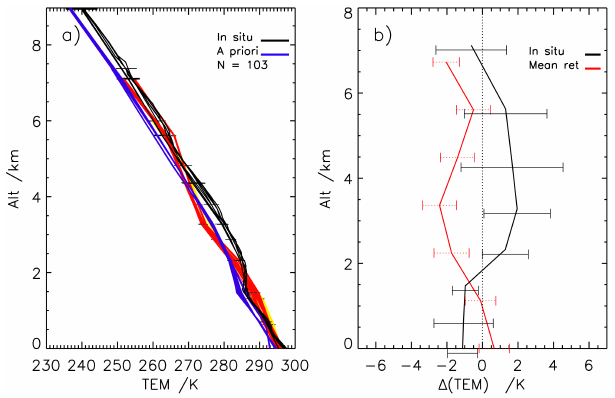
Figure 7. (a) A total of 103 individual temperature retrieval pro- files across flight B290 colour coded for observer (flight) altitude. In situ dropsonde (black) and a priori profiles (blue) are also shown with 1 σ variability bars. (b) Mean-difference profiles (binned and evaluated at eight equidistant vertical levels) for retrieved (red), and in situ (black), differenced relative to the mean in situ profile af- ter convolution with the ARIES averaging kernel. The root mean square retrieval uncertainty (total error) is shown by the red bars and the in situ 1 σ variability is shown as black bars at each vertical